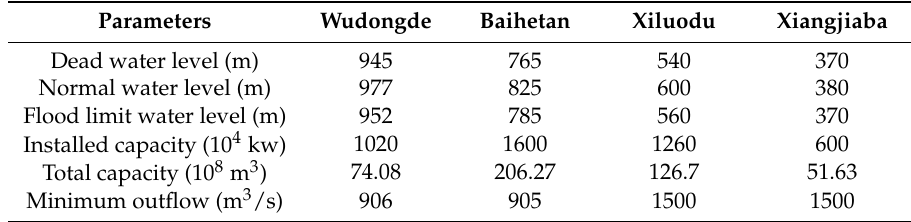
Figure 4. Hydrological stations in the Jinsha River. Table 1. Main parameters of the four cascade hydropower stations in the Jinsha